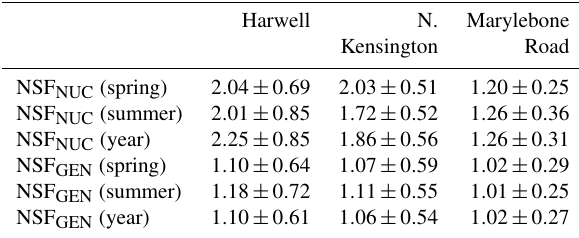
Table 2. Annual and seasonal NSF for all areas of study. Harwell